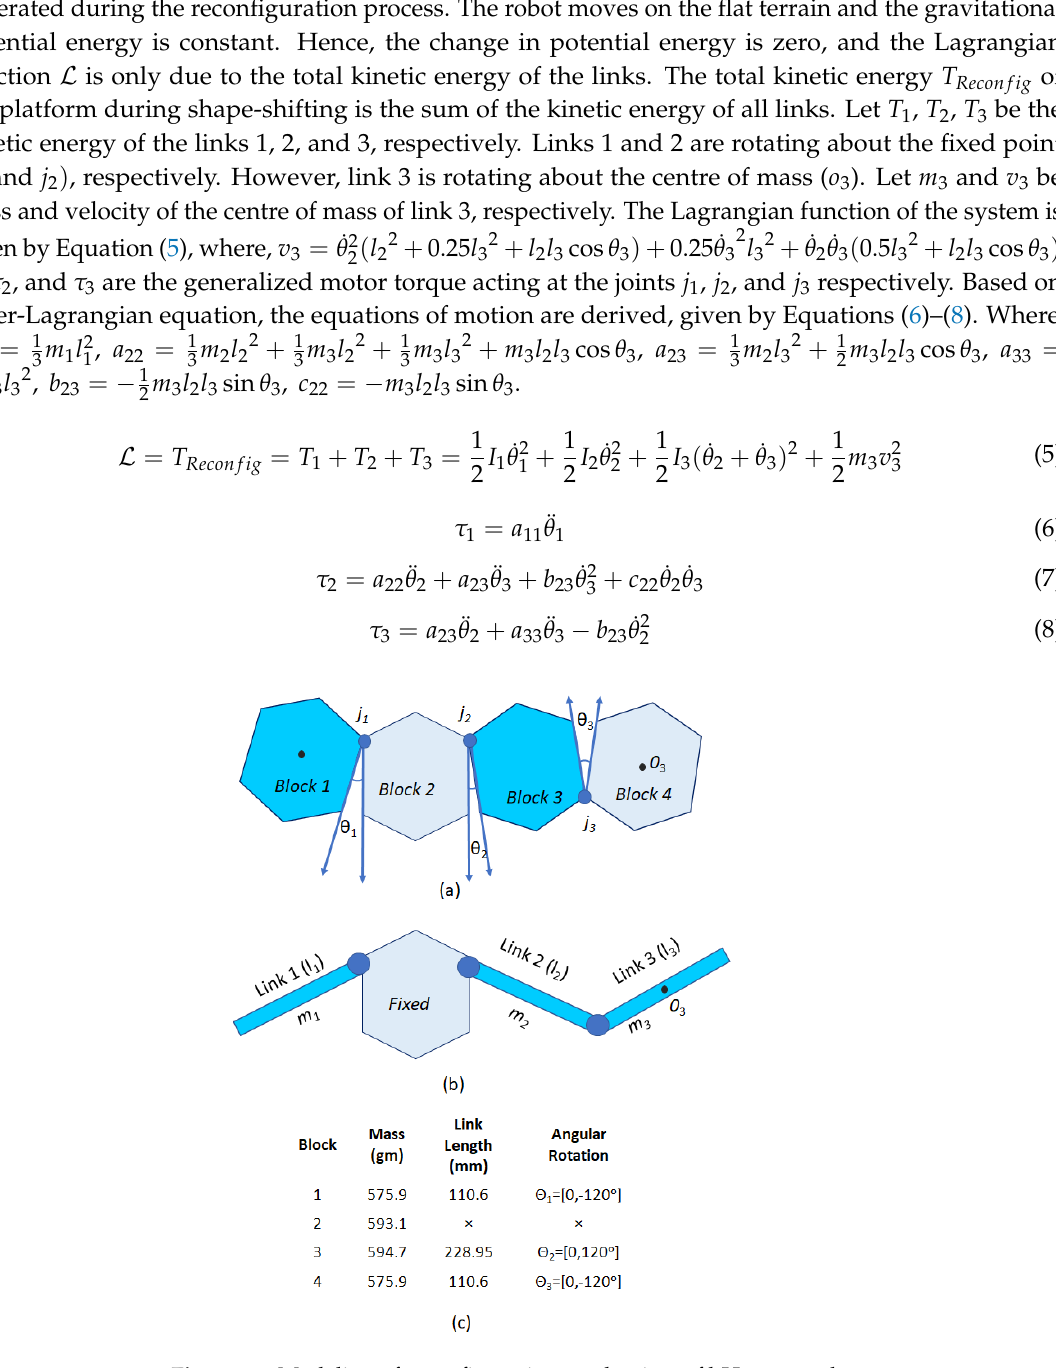
Figure 10. Modeling of reconfiguration mechanism of